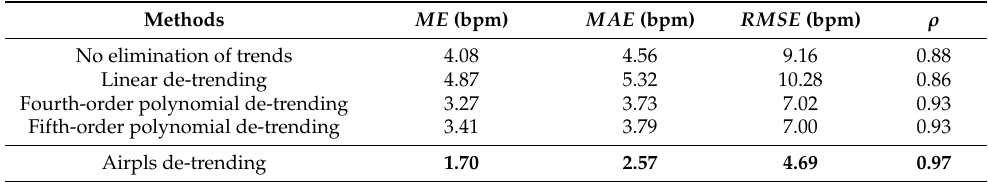
Figure 6. Scatter plot comparing the ground-truth H gt and the predicted H pred on COHFACE dataset. The dark blue points indicate the average heart rate estimation under good conditions, and the light blue points indicate the average heart rate estimation under nature conditions. Table 3. Performance of heart rate estimation on UBFC dataset shows the superiority of the baseline elimination (best performance in